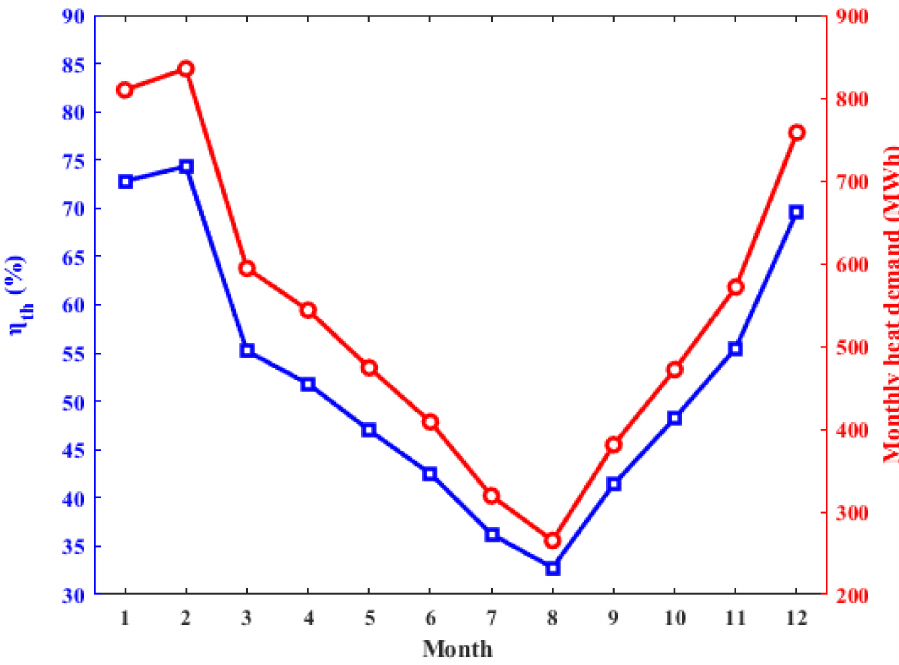
Figure 15. Monthly heat demand and thermal efficiency of the CHP system.